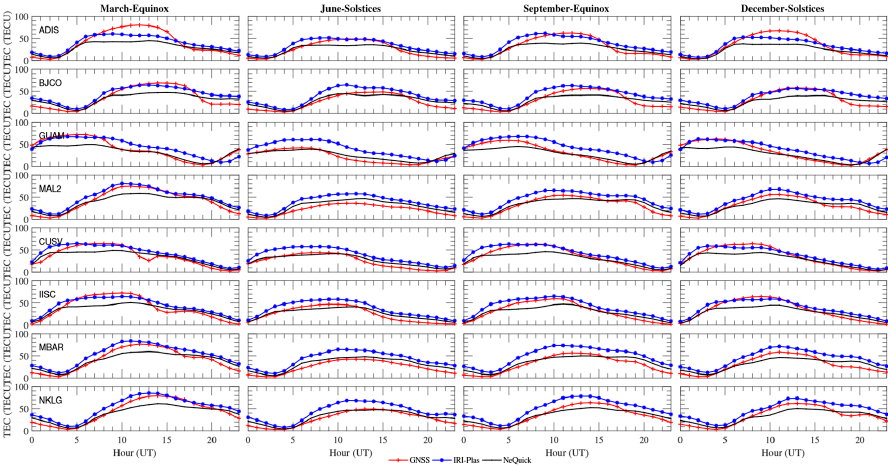
Figure 3. Averaged seasonal variation of GPS-TEC with corresponding modeled TEC for the entire stations considered in 2014.